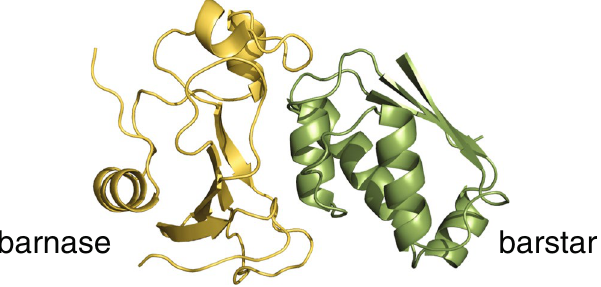
Figure 1. Structure of the barnase–barstar